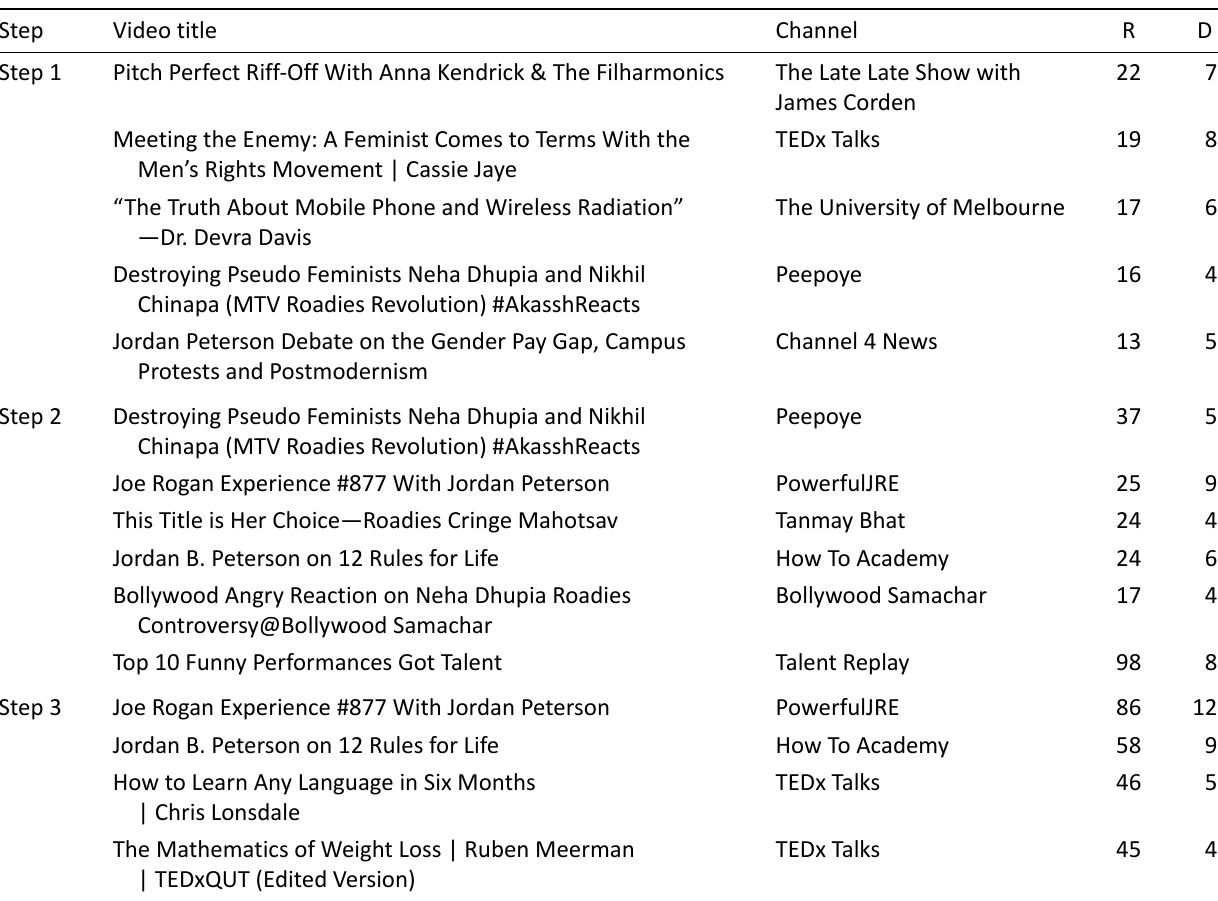
Table 4. Top five videos recommended for “feminism” at each step.